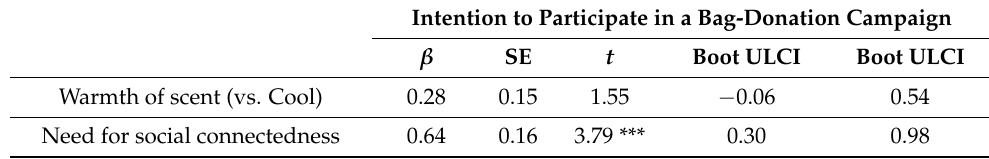
Table 1. Direct Effect between the Experience of Warmth and Intentions toward Prosocial Behavior. Intention to Participate in a Bag-Donation Campaign β SE t Boot ULCI Boot ULCI Warmth of scent (vs. Cool) 0.28 0.15 1.55 − 0.06 0.54 Need for social connectedness 0.64 0.16 3.79 *** 0.30 0.98